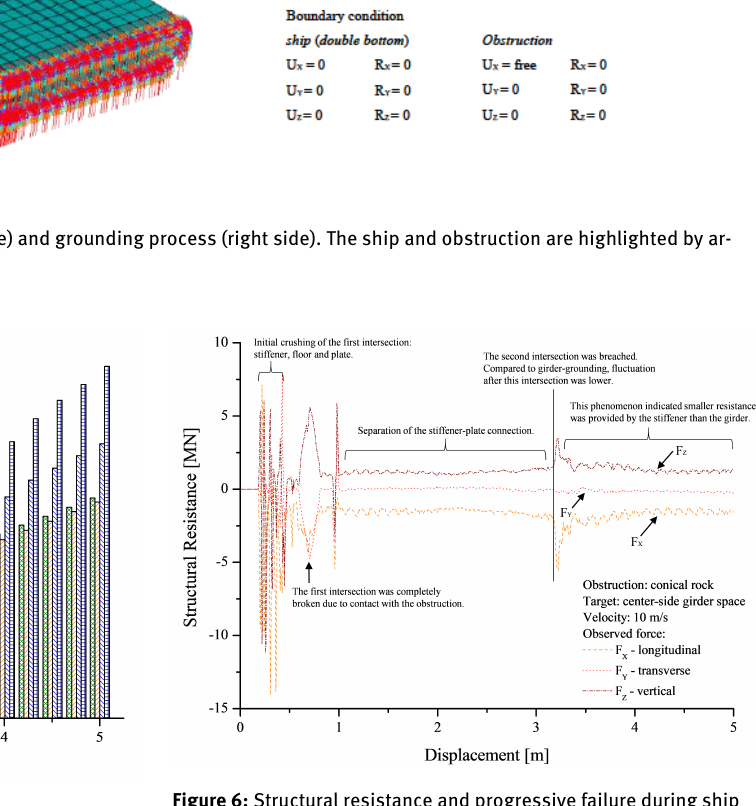
Figure 5: Results of the internal energy for the proposed target loca- tions on the double bottom.